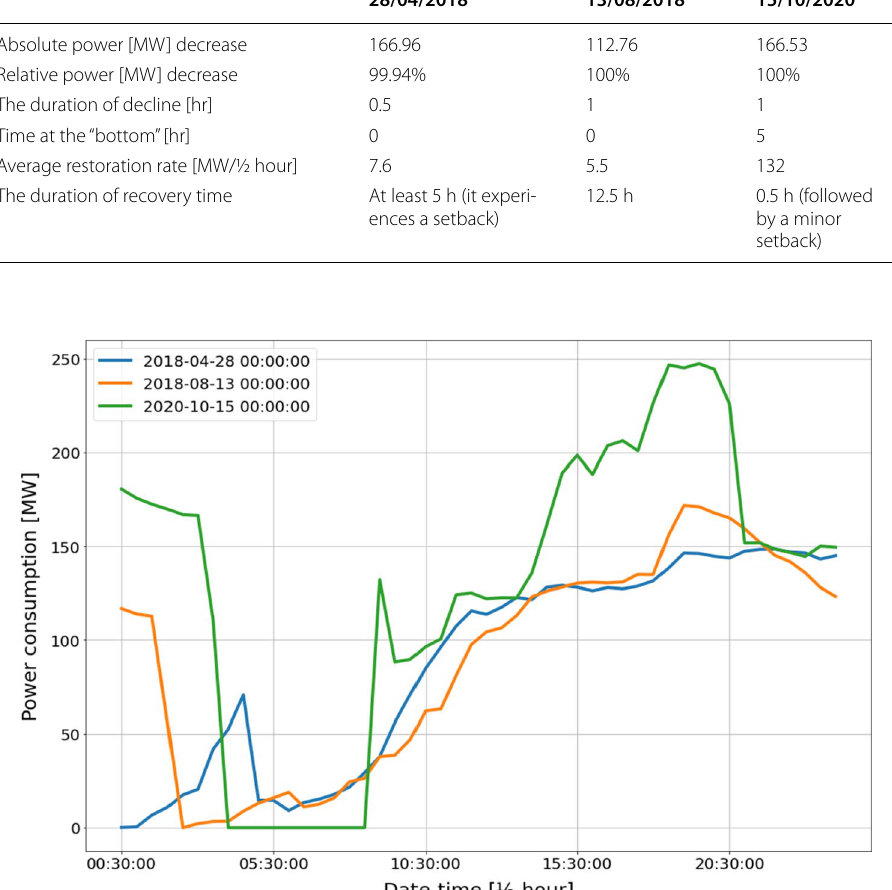
Fig. 30 Three natural disaster-independent electrical fault